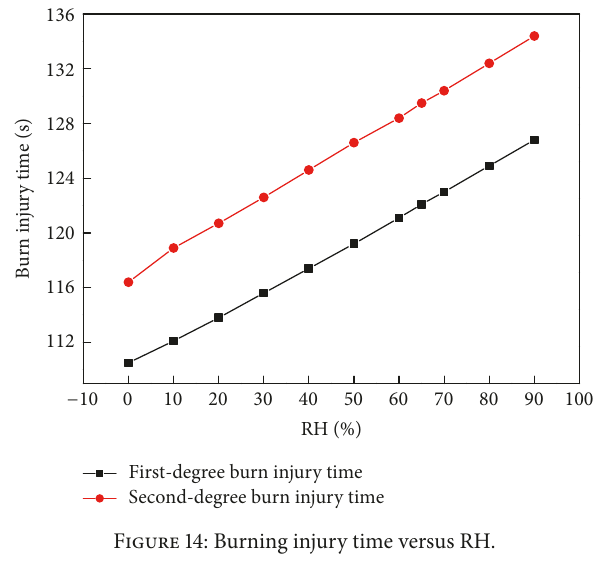
Figure 14: Burning injury time versus RH.